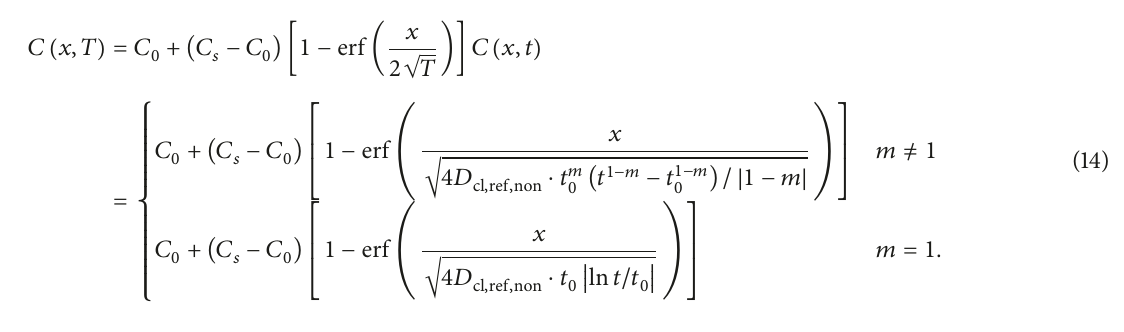
Considering three boundary conditions, (1) the content of chloride ion on concrete surface is constant, 𝐶(𝑥 = 0, 𝑡) = 𝐶 𝑠 ; (2) the content of chloride ion in concrete is 𝐶 0 at the initial